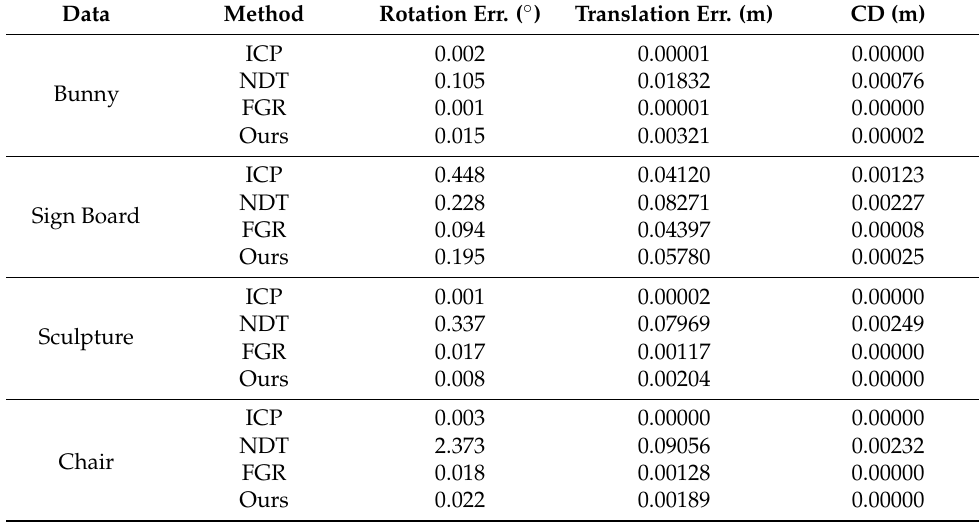
Table 1. Performance on Clean